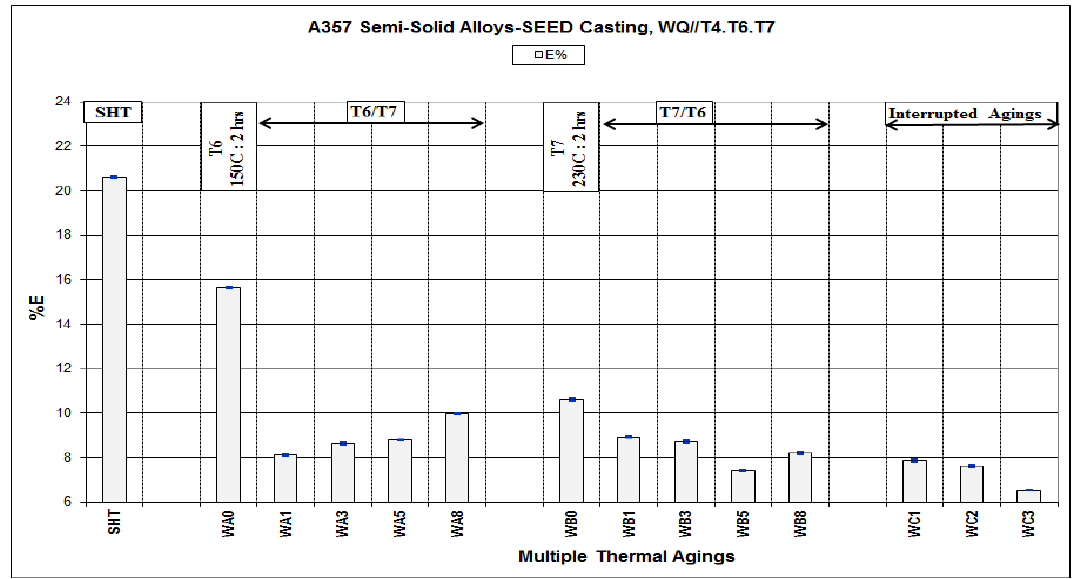
Figure 4. Average values of elongation (El %) of water quenching A357-SSM heat treated using multiple thermal aging treatments.